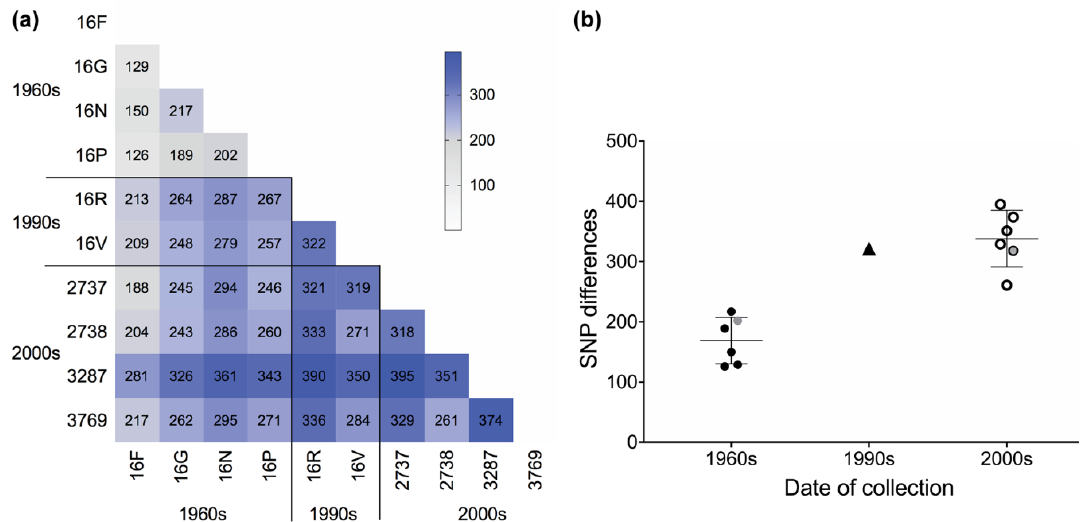
ff erences between isolates of Dothistroma septosporum. ( a ) Heatmap of Figure 1. SNP differences between isolates of Dothistroma septosporum. ( a ) Heatmap of whole-genome Figure 1. SNP di